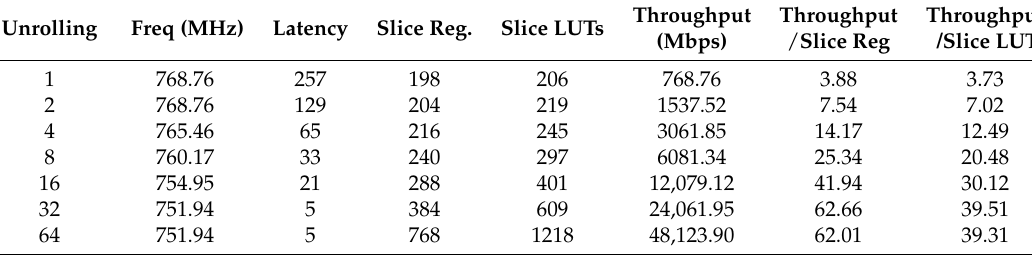
Table 9. Grain-128 synthesis results (Xilinx Virtex7, device